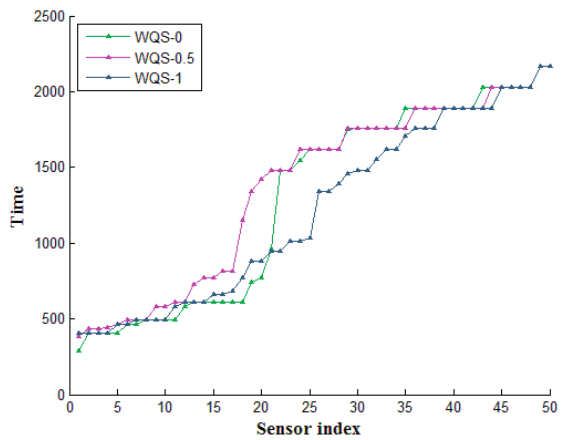
Figure 11. The network time on different sensor